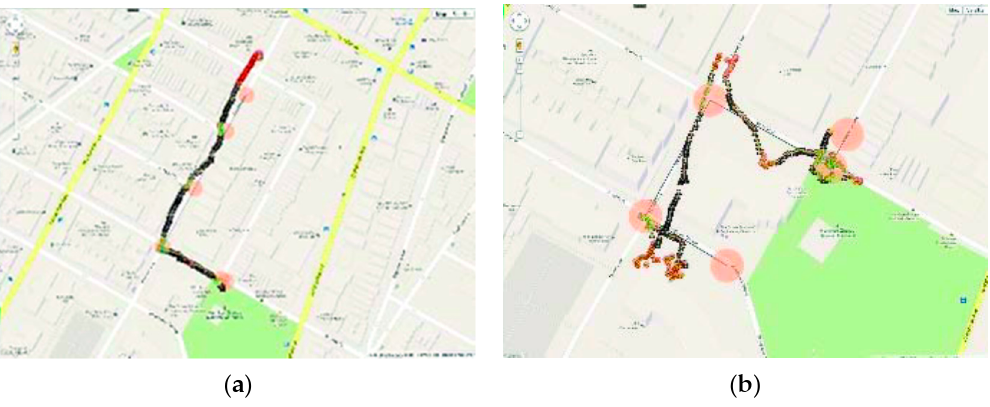
Figure 15. ( a ) The results of the device’s orientation in residential area; ( b ) The results of the device’s orientation in civilian [34].